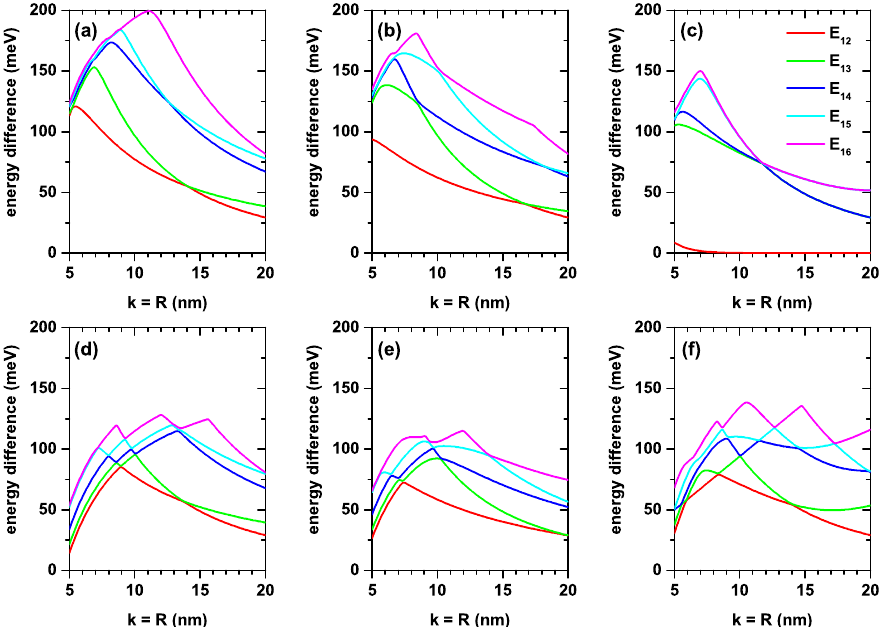
Figure 5. Energy difference between the lowest confined electron states ( E n − E 1 , n = 2,3,4,5,6) within the CQD as a function of the simultaneous variation of the k -width in the axial direction and the R -radius in the radial direction. Calculations are for zero ( a – c ) and F = 50kV/cm ( d – f ) with l = 0. The results are reported for the three considered finite axial confinement potentials: V 2 ( z ) ( a , d ), V 3 ( z ) ( b , e ) and V 4 ( z ) ( c , f